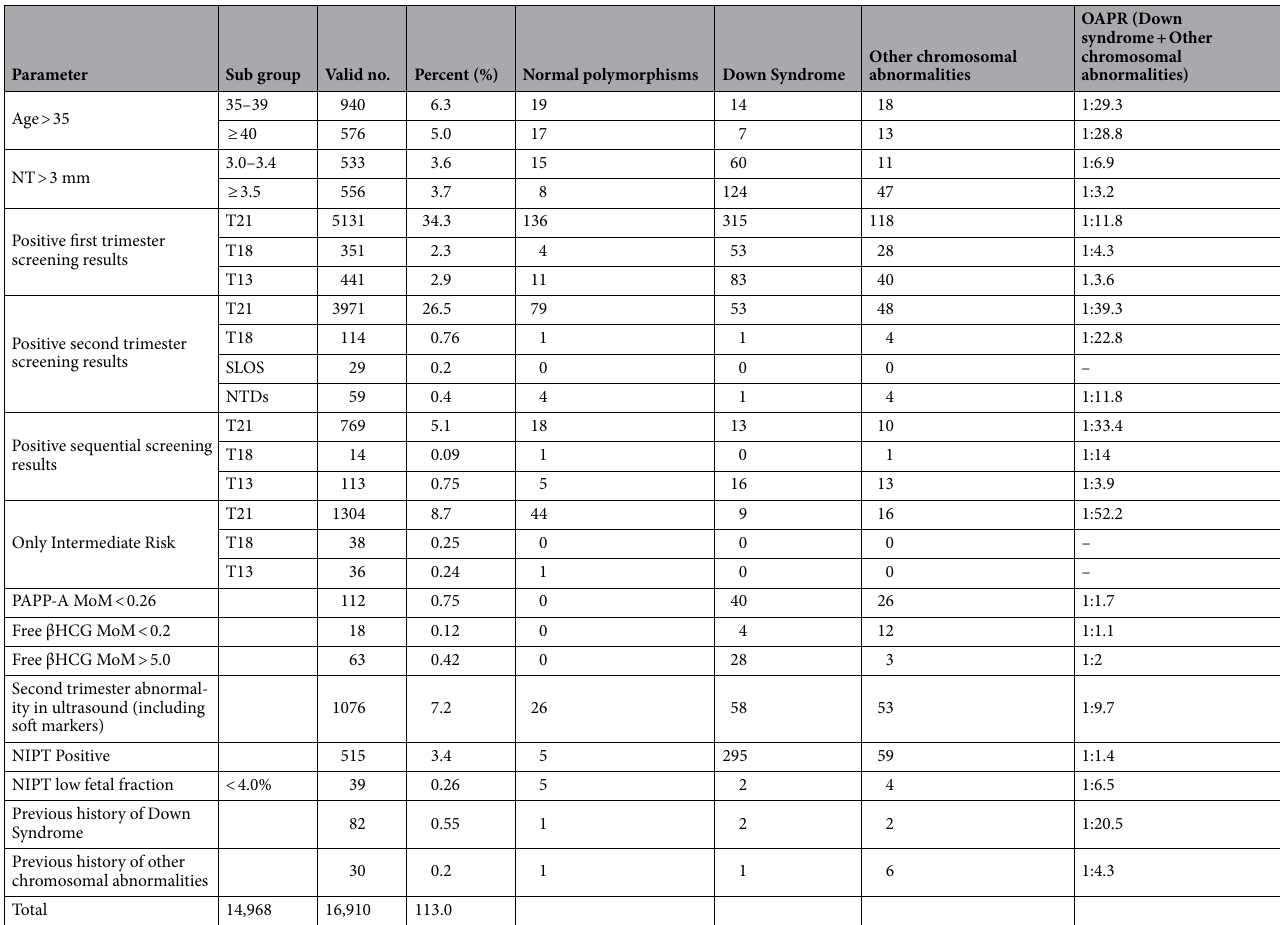
Table 4. Frequency of normal polymorphisms, Down syndrome and other chromosomal abnormalities based on the defined indication for amniocentesis (MoM: multiple of the median, NIPT: non-invasive prenatal